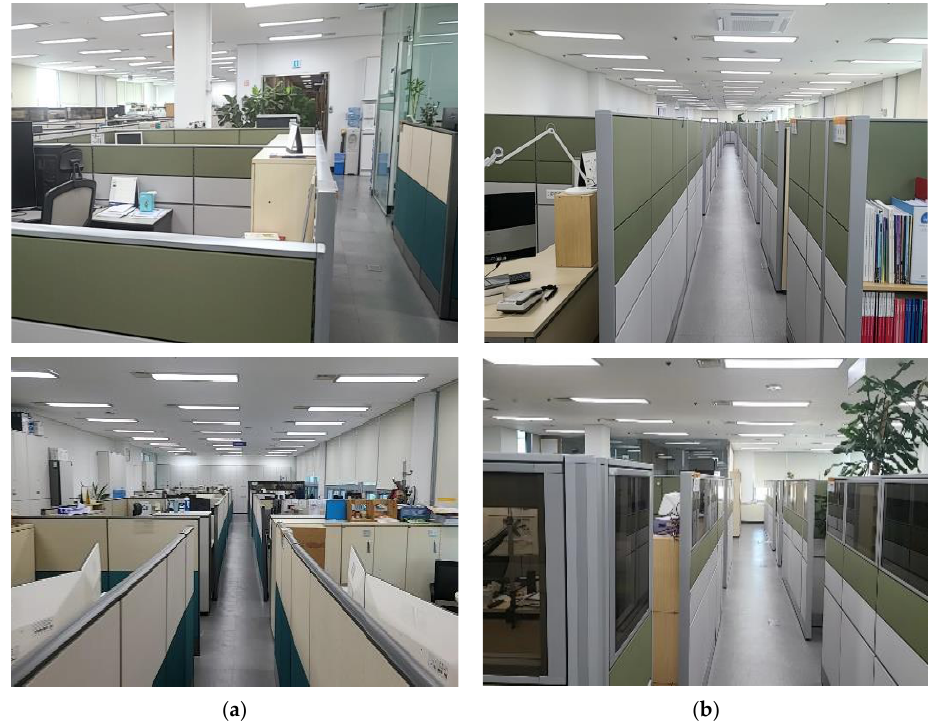
Figure 2. A panoramic view according to the type of office (( a ) = administrator, ( b ) = researcher).